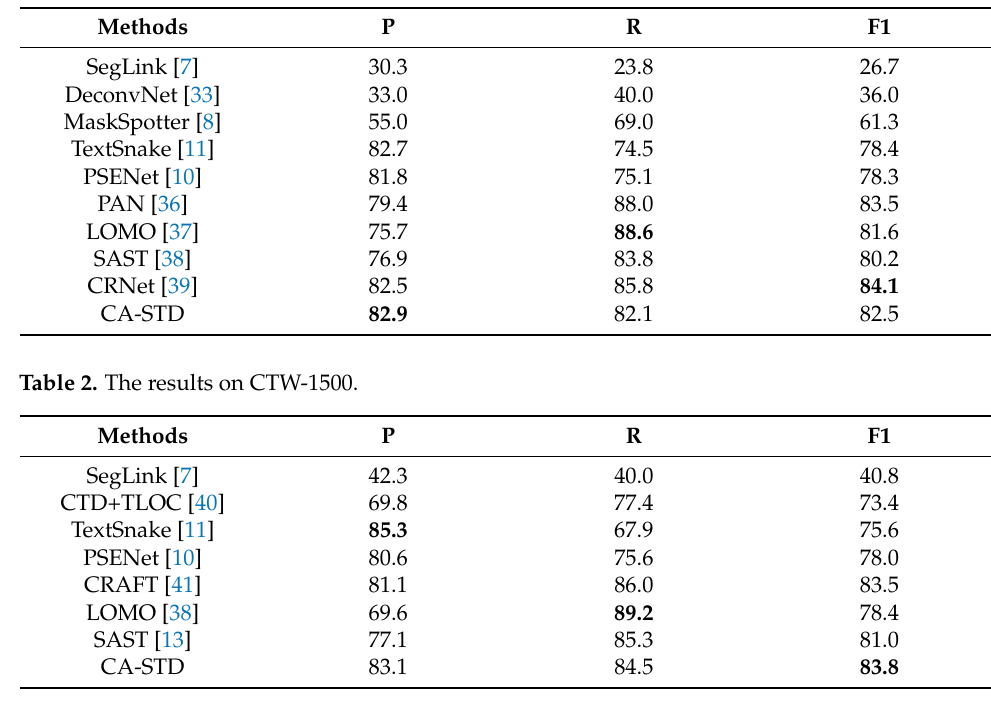
Table 1. The results on TotalText.